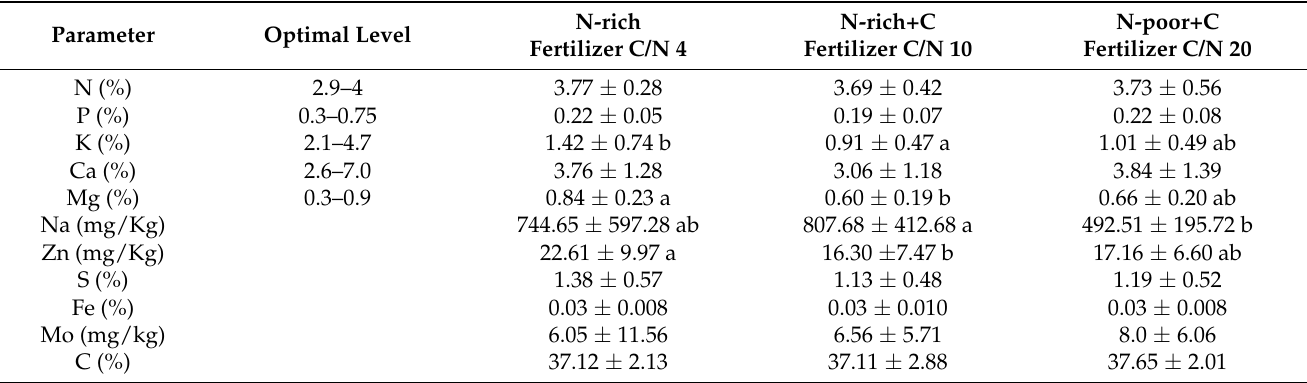
Table 5. Leaf mineral nutrients at the beginning of tomato curdling in plants treated with organic fertilization. The reference for optimal levels is from Villar and Villar (2016) [34].